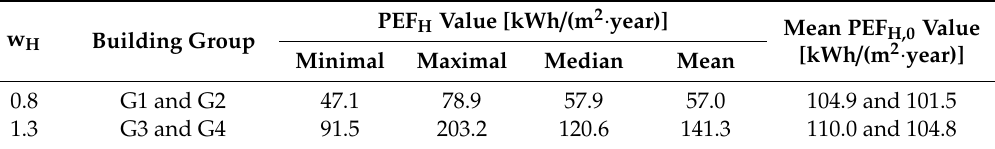
Table 9. Values of PEF H factor after thermal retrofitting.